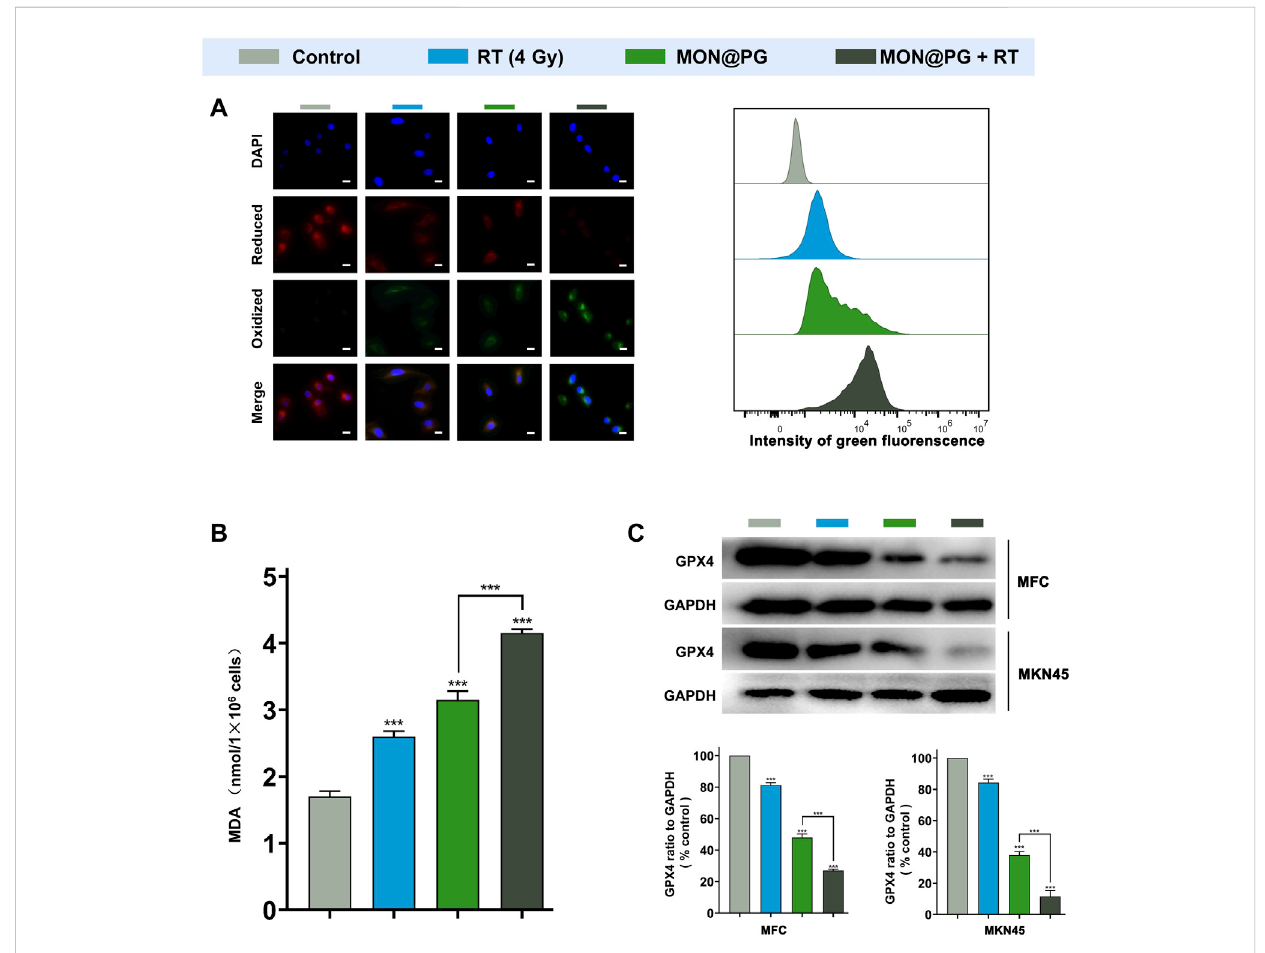
FIGURE 3 Ferroptosis levels of MFC cells with various treatments. (A) Representative CLSM fl uorescence images of C11-BODIPY (581/591) reported lipid peroxidation (left) and fl ow cytometry of its green fl uorescence (right). Scale bars: 10 μ m. (B) MDA assay of MFC cells following different treatments. (C) Western blotImagingandAnalysis ofGPX4proteinexpressioninbothMFCandMKN45cells. Outcomes aredisplayedas mean± SD(n=3,*** p <